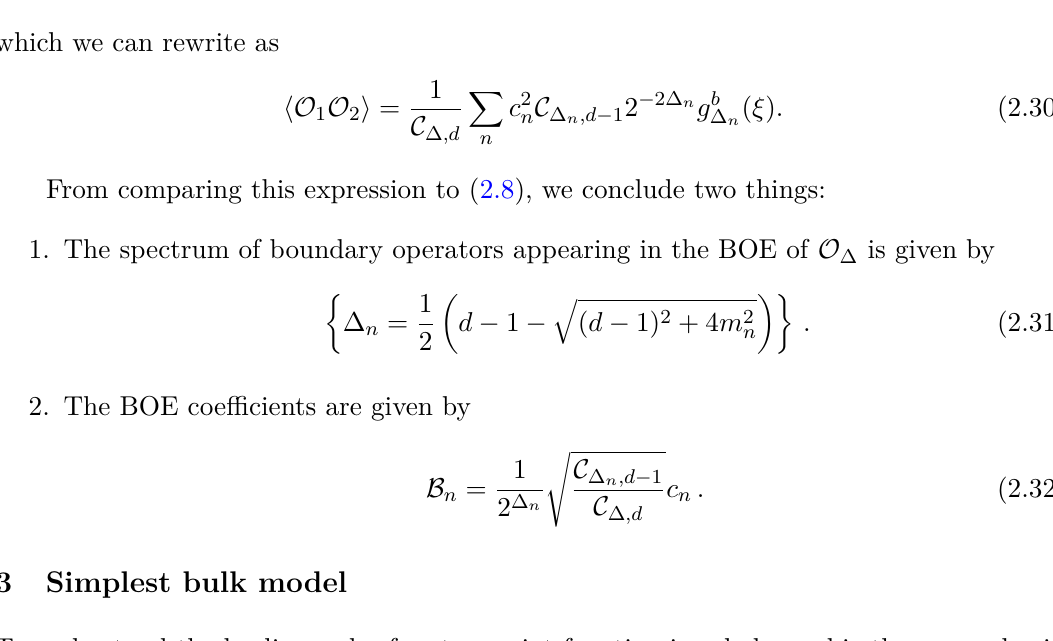
foliation of AdS d d +1